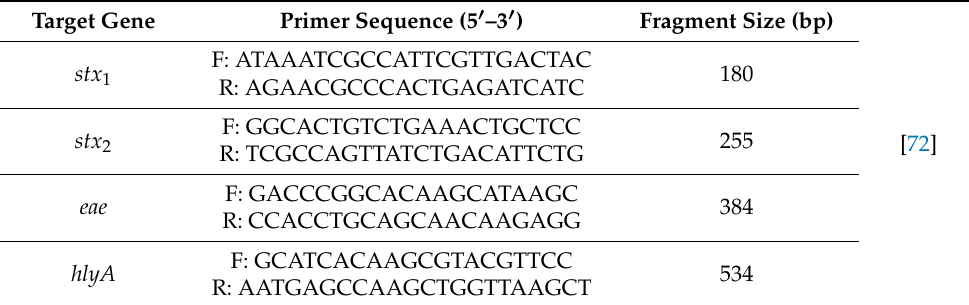
Table 9. Primers used were supplied from Metabion